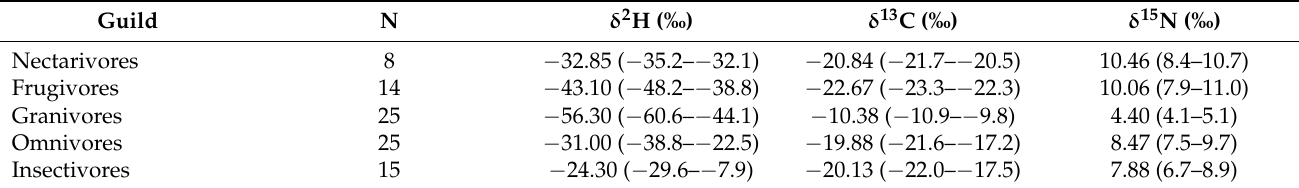
Table 2. Median and interquartile ranges for the various isotopes by guild. The second panel summarizes between-group differences based on Tukey post-hoc tests, highlighting between-group differences in bold (see text). Guild